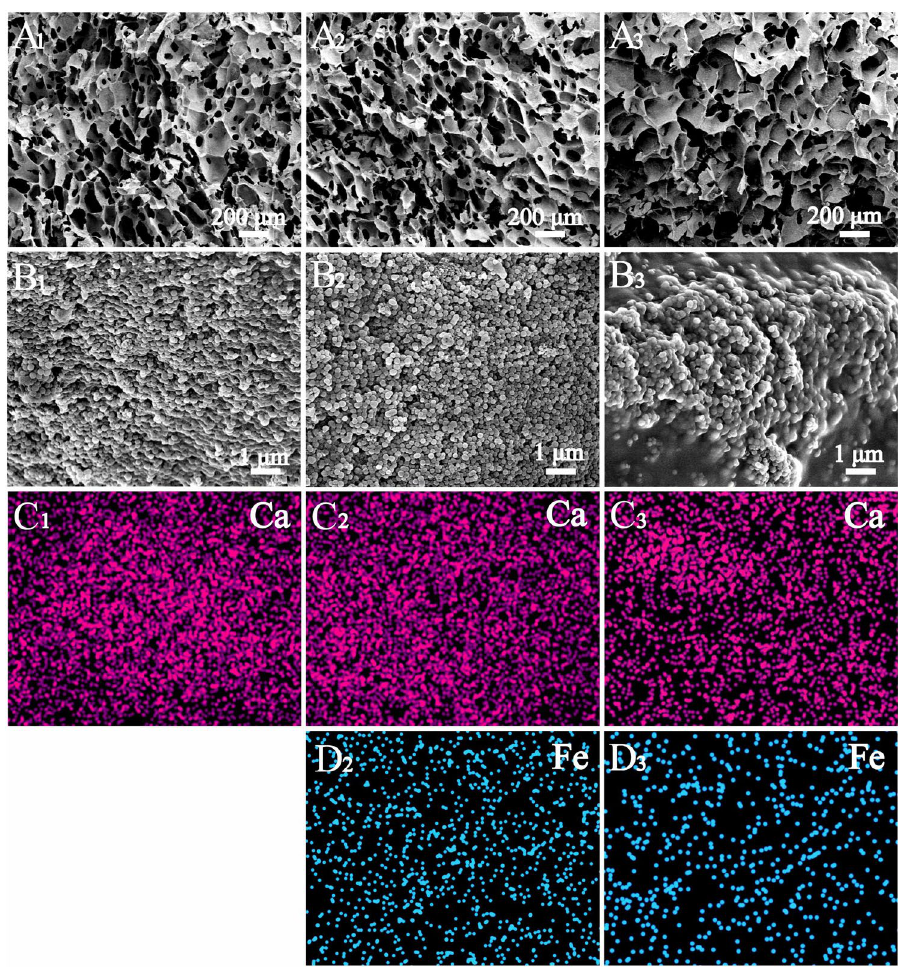
Figure 3. The key elements distribution of on scaffolds evaluated by SEM. Ca and Fe element distribution images of samples: (A1, B1, C1) CSC scaffolds, (A2, B2, C2, D2) MCSC 1:7 scaffolds and (A3, B3, C3, D3) MCSC 1:3 scaffolds. SEM, emission scanning electron